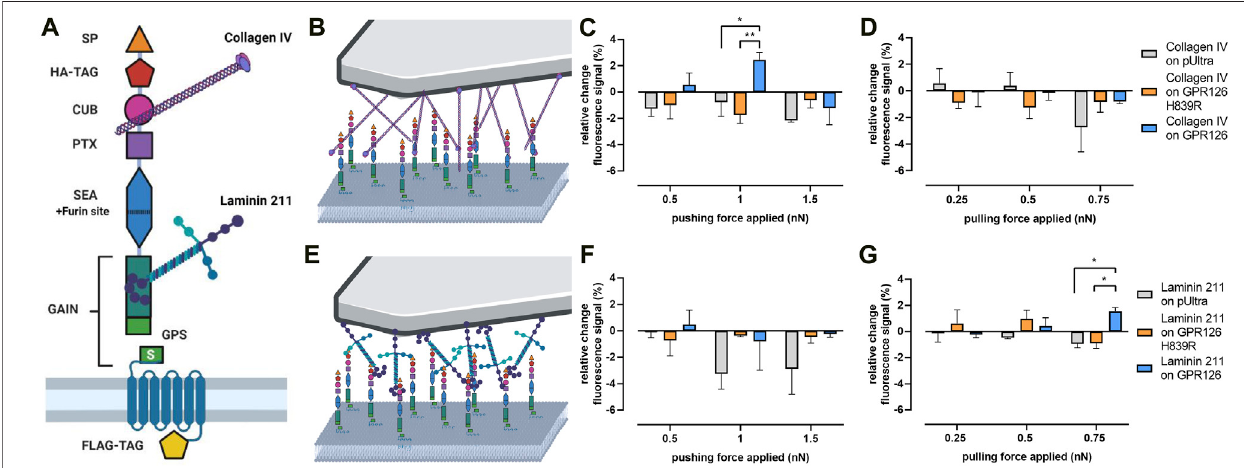
FIGURE 4 | Mechano-activation of GPR126 via its ligands. (A) Domain architecture of human GPR126 with the binding sites of its ligands, collagen IV and laminin 211, is depicted. (B,E) Schematic demonstrating the AFM setup with (B) collagen IV- and (E) laminin 211-coated cantilevers. (C,D) Changes in Pink Flamindo fl uorescenceintensityafterapplyingavaryingpushing (C) orpulling (D) forceover60swithacollagenIV – coatedcantilever. (F,G) ChangesinPinkFlamindo fl uorescence intensity after applying a pushing (F) or pulling (G) force over 60s with a laminin 211-coated cantilever. Data are given as the means ± SEM of three different experiments, each measuring three individual cells for each force. Statistics were performed as two-way ANOVA (C) : effect of construct p = 0.1452, effect of force applied p = 0.0635,interaction construct × force applied p =0.0298; (D) : effect of construct p =0.8096, effect offorce applied p = 0.1748, interaction construct × force applied p = 0.2744; (F) : effect of construct p = 0.0537, effect of force applied p = 0.4536, interaction construct × force applied p = 0,7286; (G) : effect of construct p = 0.2225, effect of force applied p = 0.5884, interaction construct × force applied p = 0.0246) in combination with Tukey ’ s post hoc analysis; * p < 0.05; ** p < 0.01. Signi fi cances in the graphs show the results of the post hoc analysis. Corresponding raw data can be found in the repository. Schematic images were created with BioRender.com.